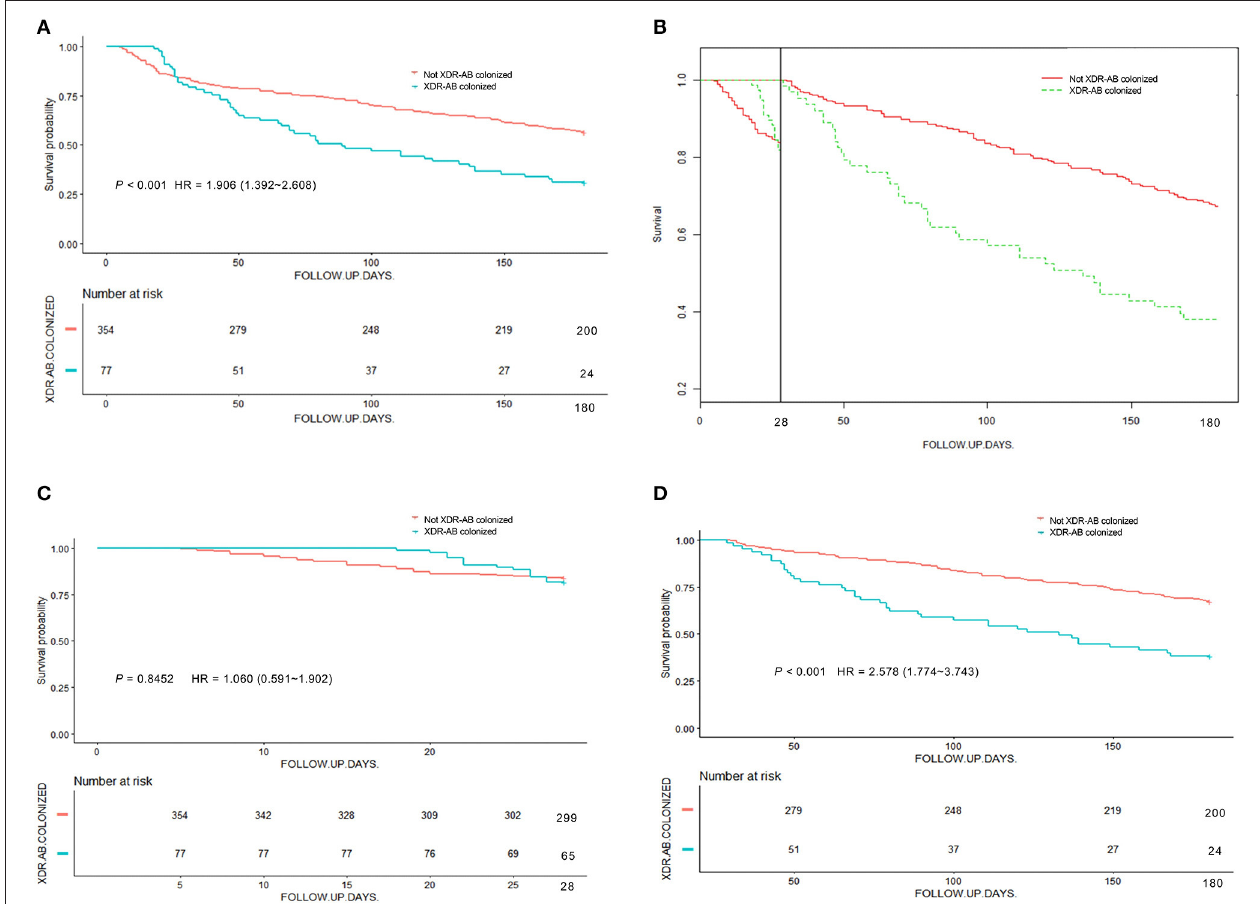
FIGURE 1 | Kaplan-Meier survival analysis stratified by XDR-AB colonization and no colonization. Survival of patients was followed for 6 months. (A) Kaplan-Meier analysis of survival in colonized and non-colonized patients. (B) Survival curves before and after 28 days. (C,D) Landmark analysis discriminating between events occurring before and after 28 days of